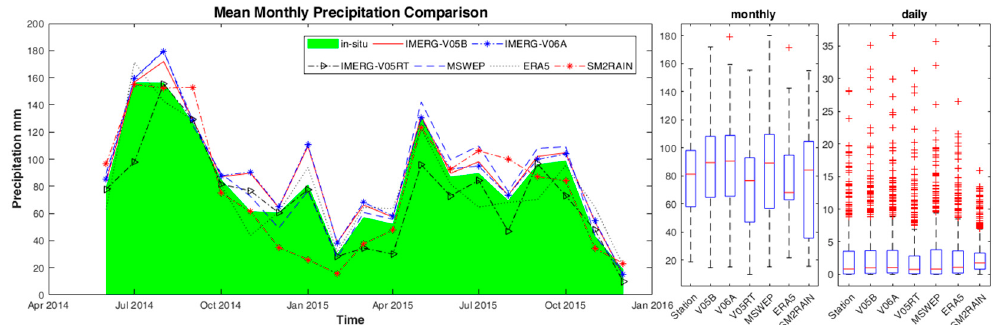
Figure 5. Time-series of mean monthly precipitation and box-plots of daily and monthly time-scales across Austria from IMERG, MSWEP, ERA5, and SM2RAIN products as compared to eHYD stations for the period of June 2014–December 2016. The center-line of each boxplot depicts the median value (50th percentile) and the box encompasses the 25th and 75th percentiles of the sample data, while the whiskers represent the extreme values, respectively.